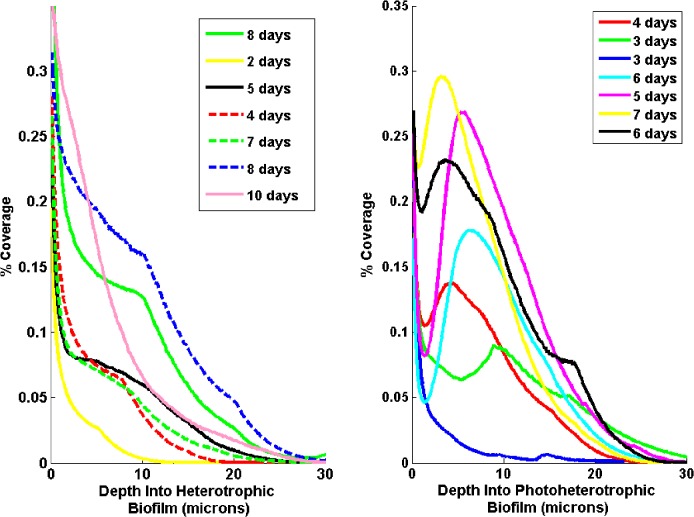
Average biofilm coverage as a function of distance from the coverslip for R. palustris biofilms grown under (A) heterotrophic and (B) photoheterotrophic conditions.Each curve is labeled by the time since inoculation and represents an average of multiple scans within each sample obtained by interpolation and binning of values at similar depths. The mean standard deviation for coverage values binned at the same depth was 2.5%. The aerobic and heterotrophically grown biofilms show coverages that decrease monotonically with increasing distance from the coverslip. Very early-growth phototrophic biofilms show similar behavior, but in later stages of growth they show a localized peak in coverage at a depth of 5–10 μm.